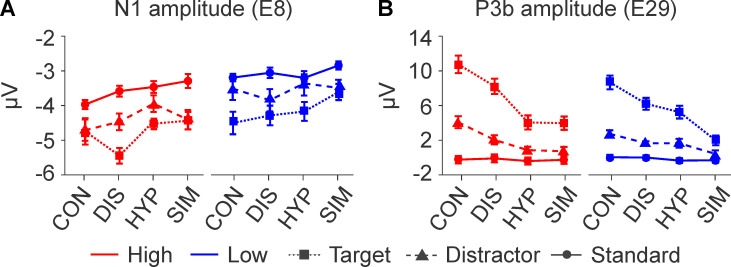
N1 and P3b amplitudes (mean ± within-subject standard error) at electrode E8 (Fz) and E29 (Pz), respectively, of high (red) and low (blue) susceptible participants in response to target (dotted line), distractor (dashed), and standard (solid) stimuli in the four experimental conditions: Control (CON), distraction (DIS), hypnosis (HYP), and simulation (SIM).